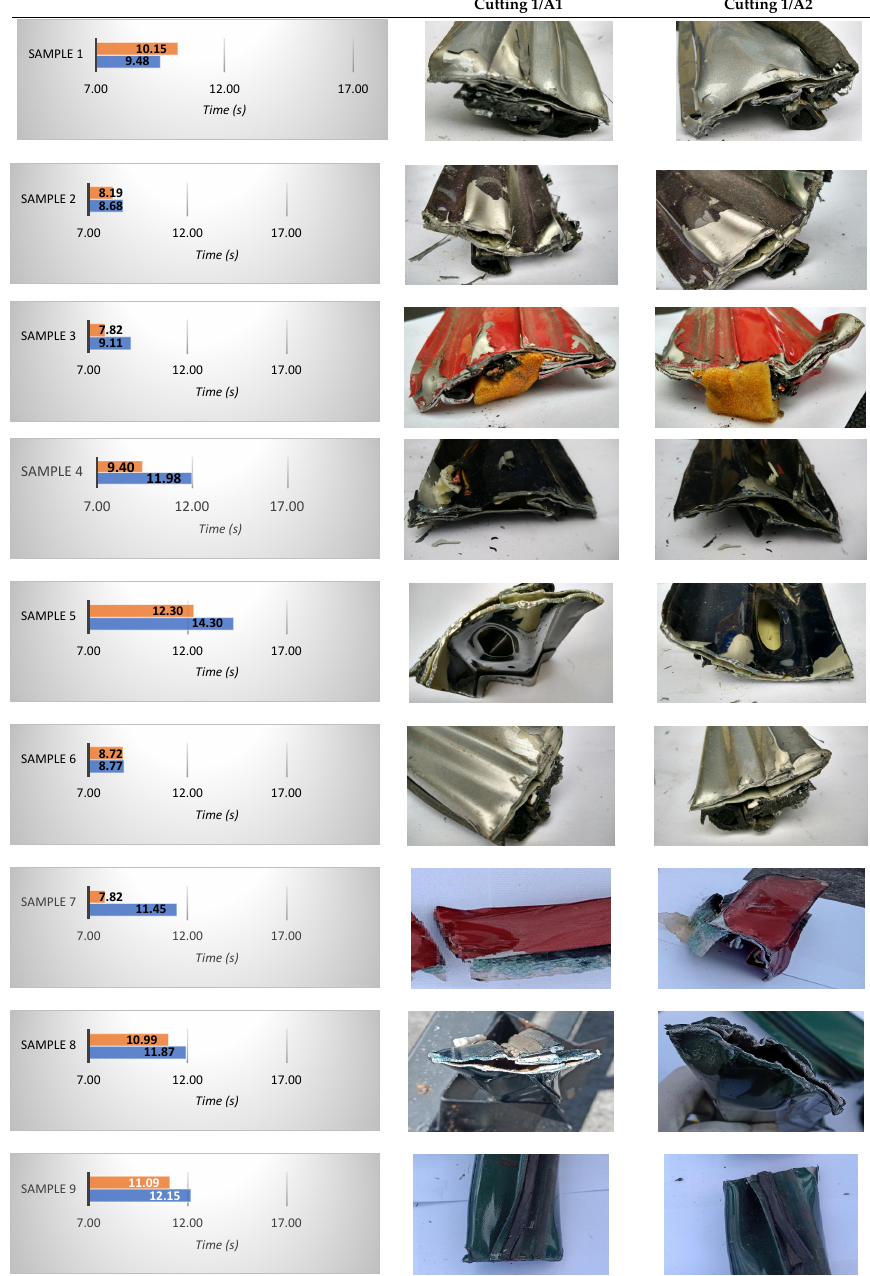
Figure 9. The results of cutting 1/A1 and 1/A2.